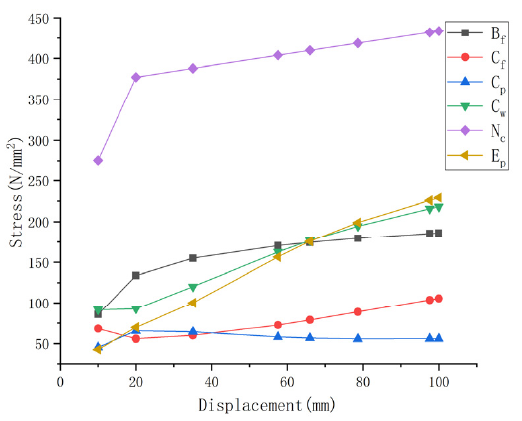
Figure 6. Prototype stress history.